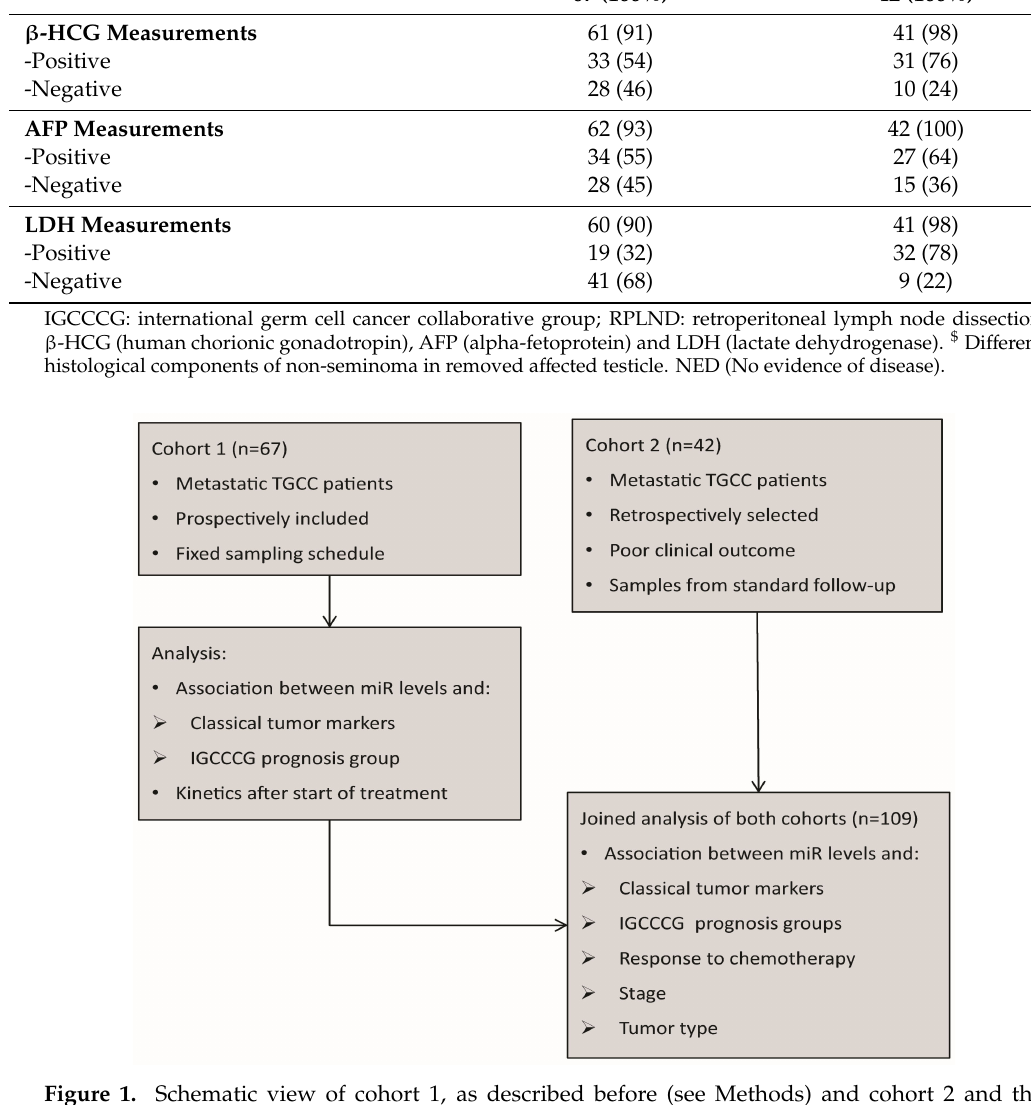
Figure 1. Schematic view of cohort 1, as described before (see Methods) and cohort 2 and the analyses